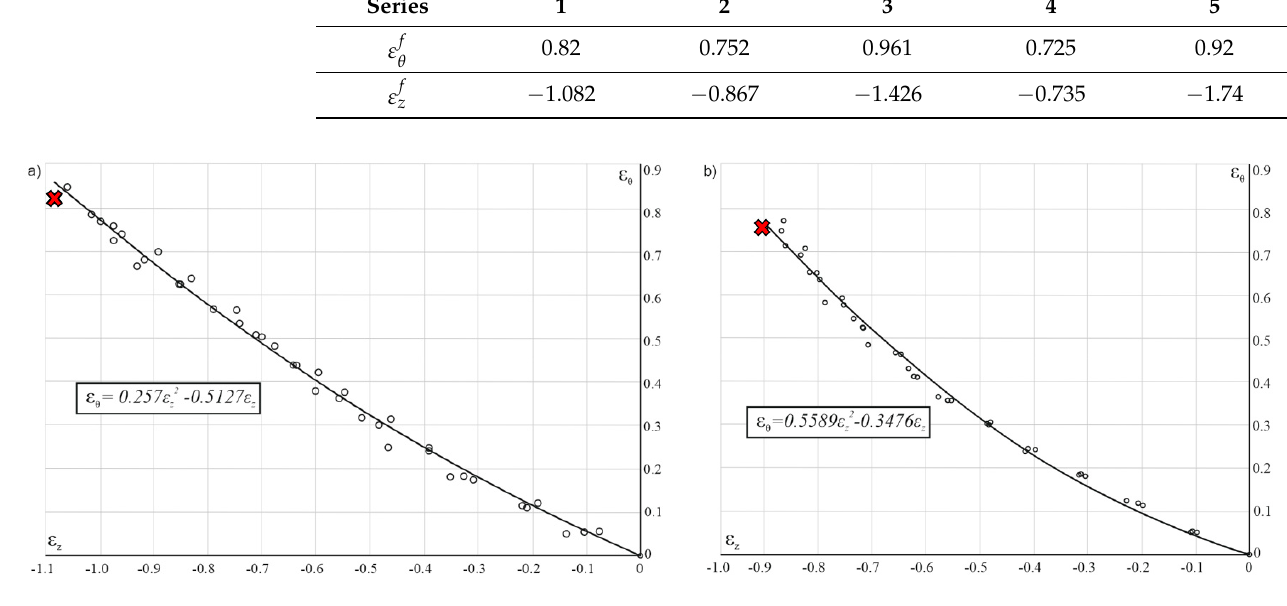
Table 3. Circumferential and axial strains at the instant of fracture initiation. Series 1 2